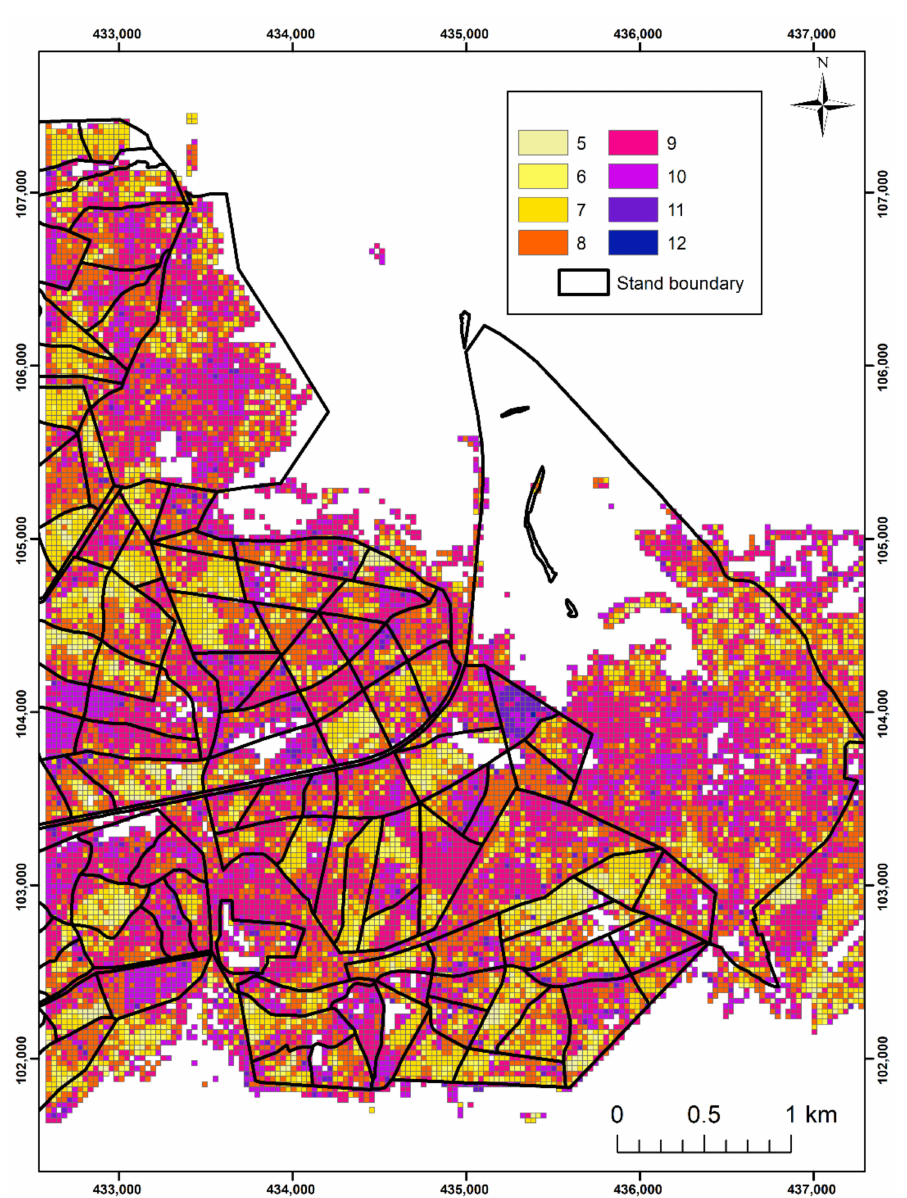
Figure 2. Predicted ‘favourable conservation status’ index map calculated for 30 × 30 m areas covering the entire study site extent. Index values ranged from 5 to 12, where lower values were observed for locations within managed coniferous stands, and higher values for cells located within the semi-ancient deciduous dominated